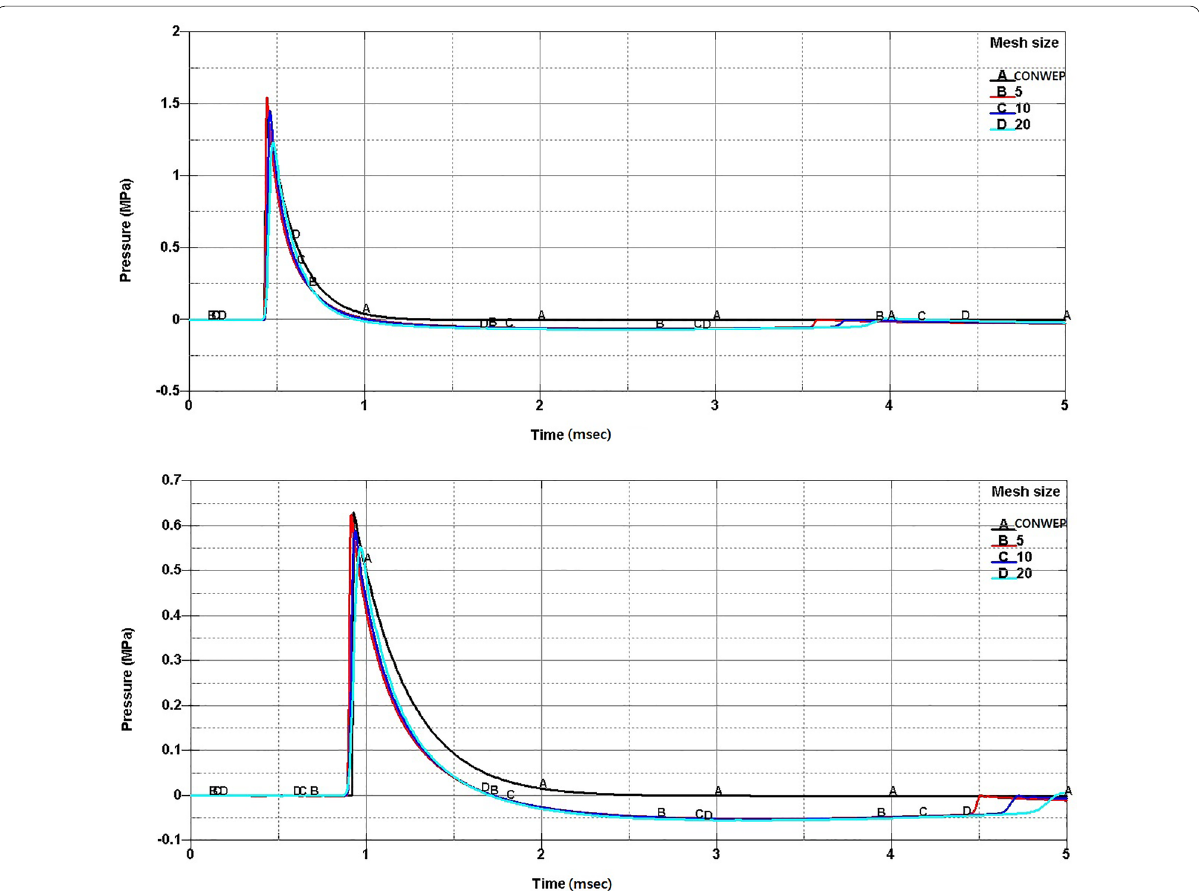
Fig. 11 Pressure behavior with time at distances of 1 m (top) and 1.5 m (bottom) from the 2 kg TNT detonation